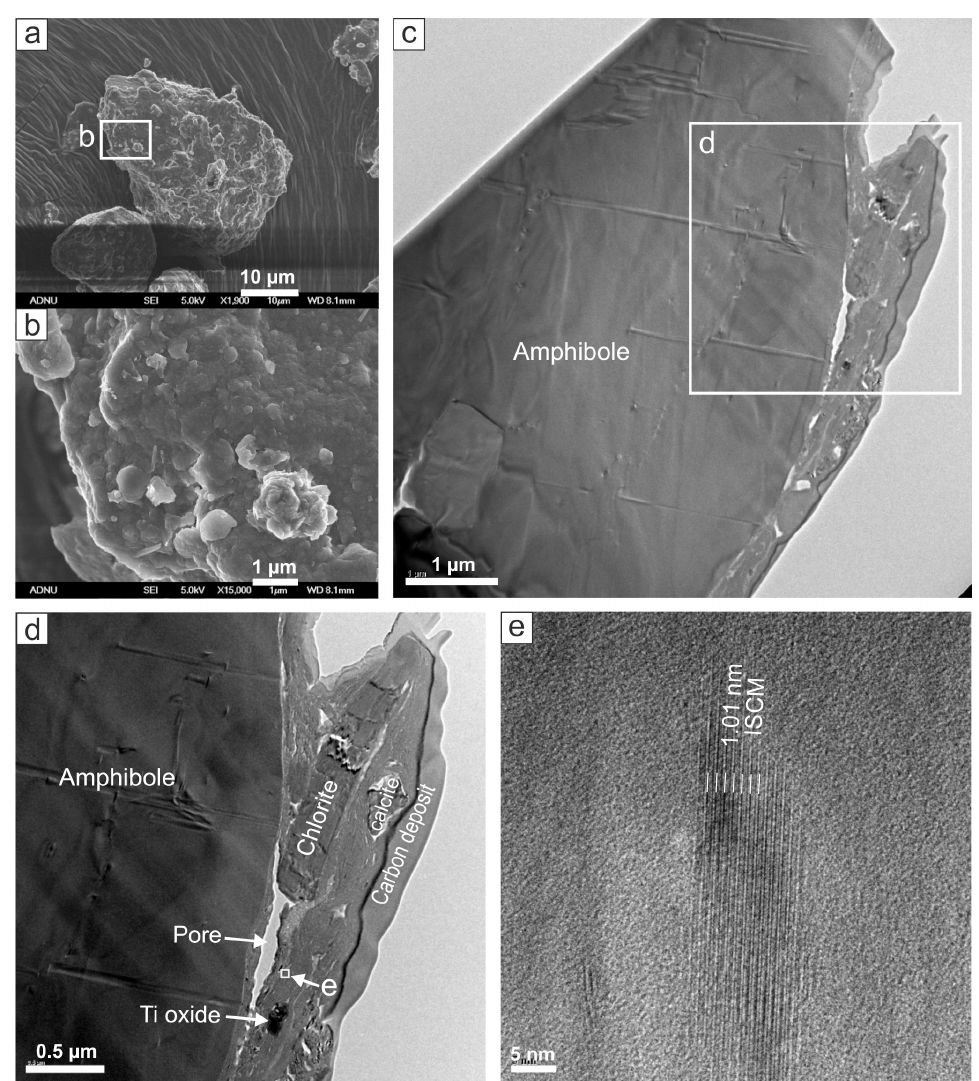
Figure 9. Amphibole-rich dust particle from 2012 Asian dust. (a) SEM image of the dust particle. (b) SEM image of the particle surface magnified from the box in (a) . (c) Overall TEM image of the FIB slice prepared from the particle in (a) . (d) TEM image magnified from the box in (c) . (e) TEM lattice fringe image of ISCMs magnified from the box in (d)